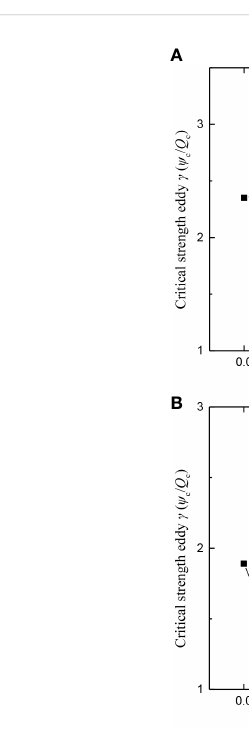
FIGURE 8 The dimensionless critical strength ( g ) of the anticyclonic eddy (A) and the cyclonic eddy (B) inducing the critical WBC transition from the penetrating to leaping regime as a function of l (= L i / L g ), where g = y c / Q c represents the critical strength of the eddy ( y c ) normalized by the critical WBC strength ( Q c ), L i is the meridional distance between the latitude of the eddy center and the latitude of the northern tip of the southern barrier, and L g is the gap width. WBC, western boundary